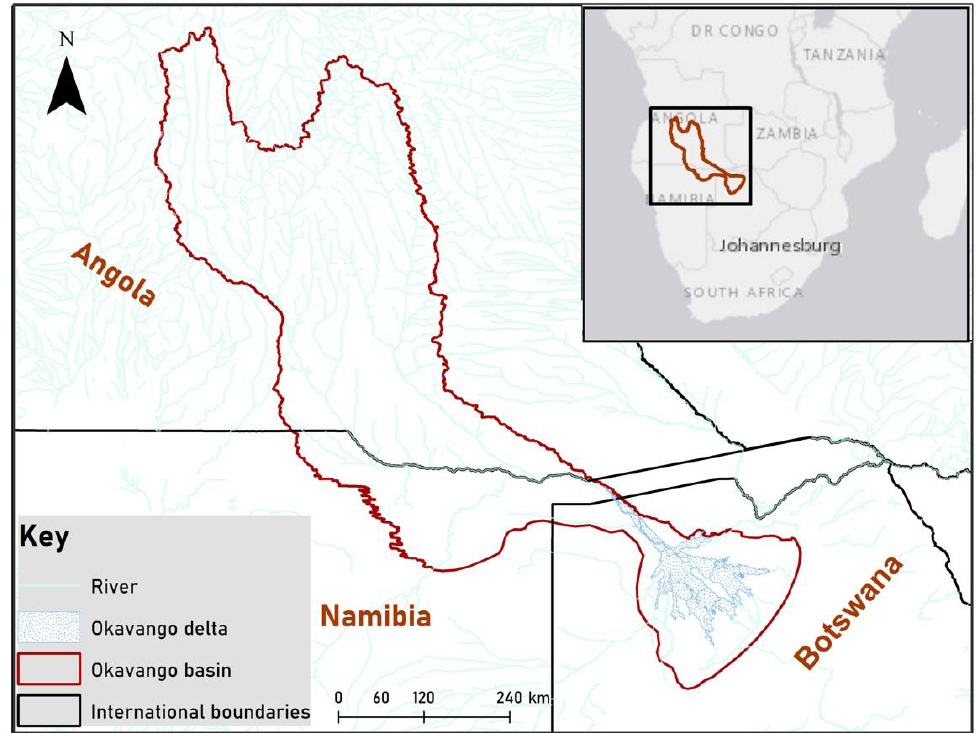
Figure 1. Study area map showing the location of the Okavango basin.